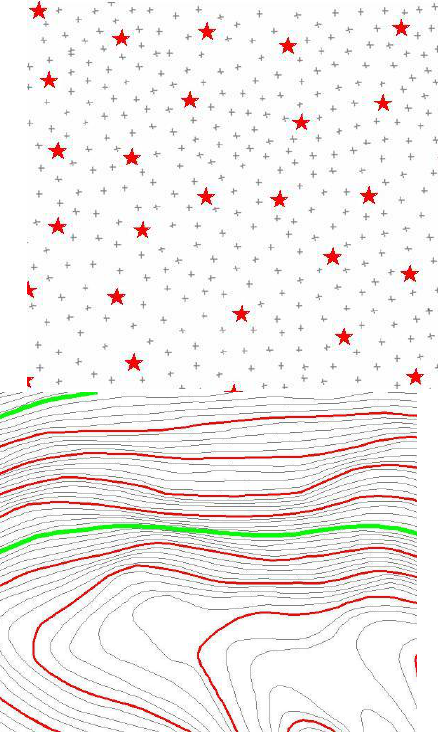
Figure 5 The terrain